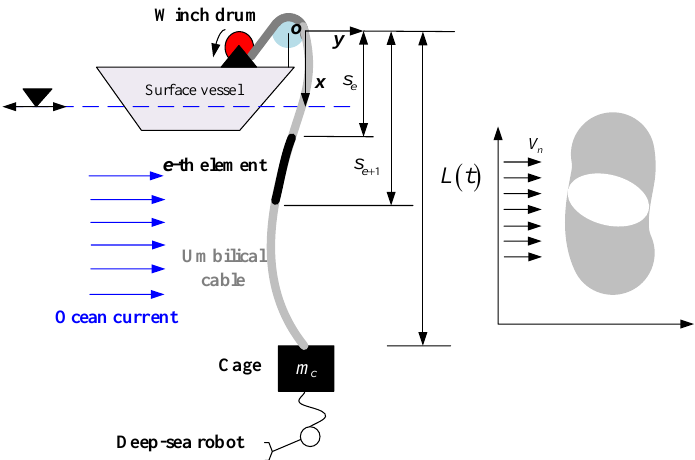
Figure 1. Deep-sea robot and hydrodynamic disturbance.